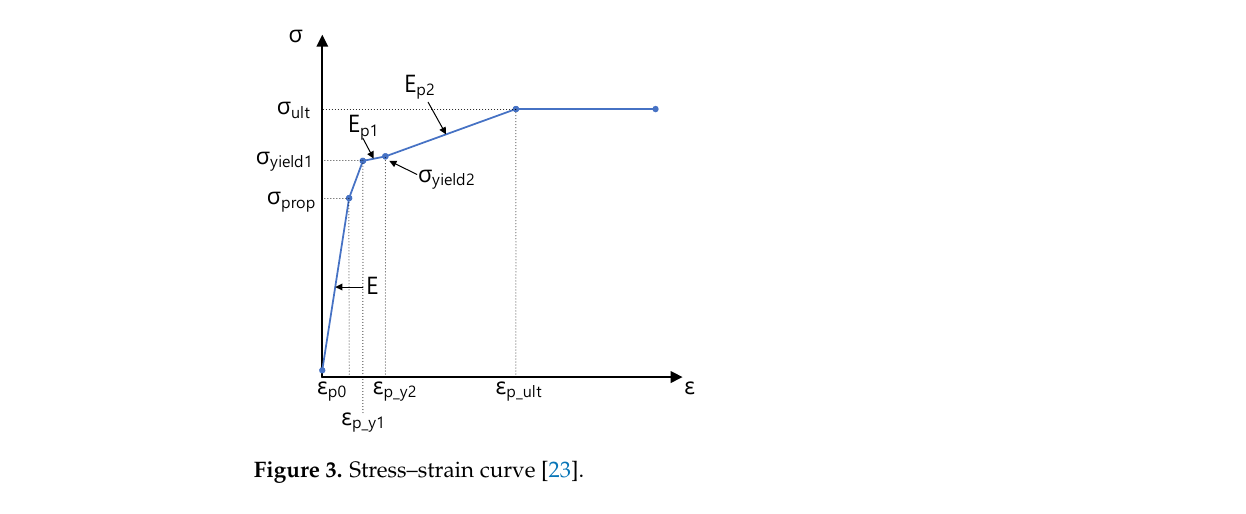
Figure 2. Geometry and corresponding finite element modeling of flange joints.